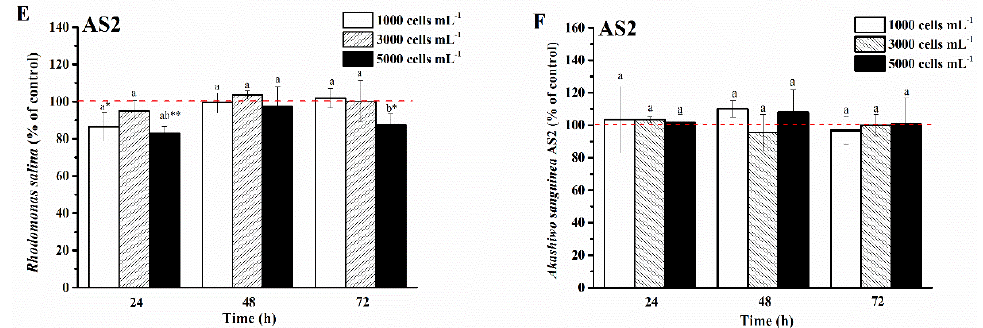
Figure 3. Strains of Akashiwo sanguinea JX13, JX14 and AS2 co-cultured with Rhodomonas salina CCMP1319. ( A , B ): JX13 co-cultured with R. salina ; ( C , D ): JX14 co-cultured with R. salina ; ( E , F ): AS2 co-cultured with R. salina . Initial cell density of R. salina was 1000 cells mL − 1 . Results are expressed in triplicate ± standard deviation (SD). Different lower-case letters (a, b, c) indicate significant differences ( p < 0.05) between treatments at the same time; * and ** indicate significant differences ( p < 0.05 and p < 0.01, respectively) between treatment and control.